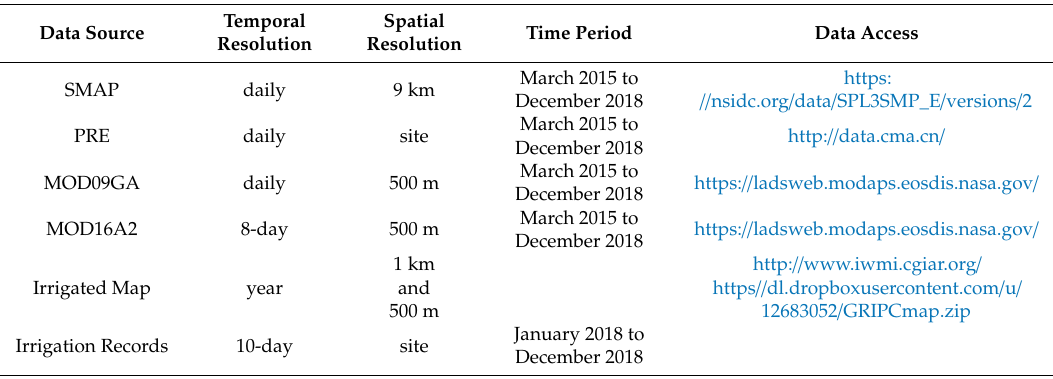
Table 1. Datasets collected in this